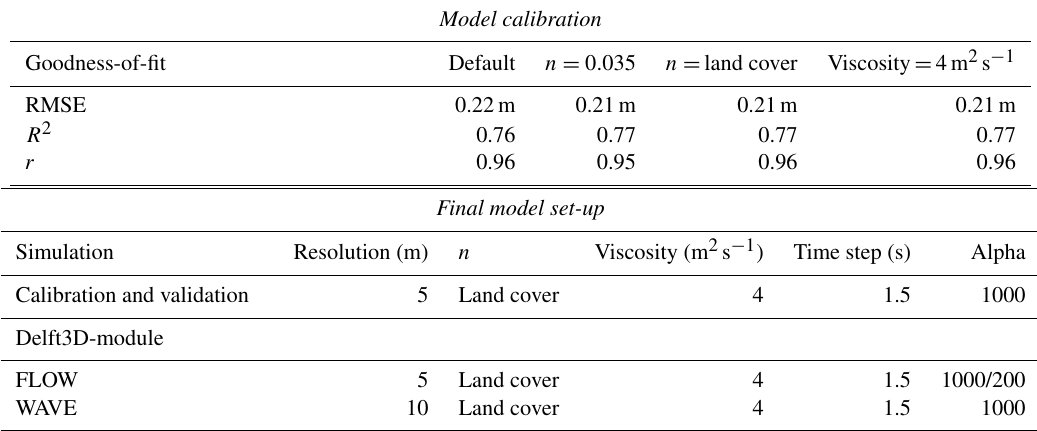
Table B1. Parameter changes during model calibration and final model set-up.